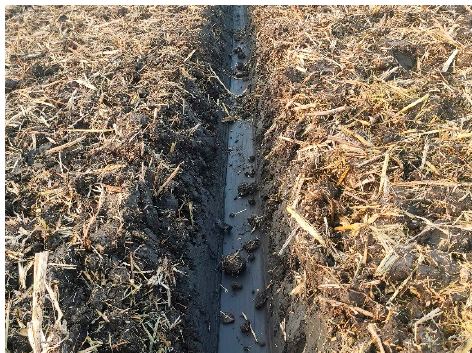
Figure 17. Drainage ditch.